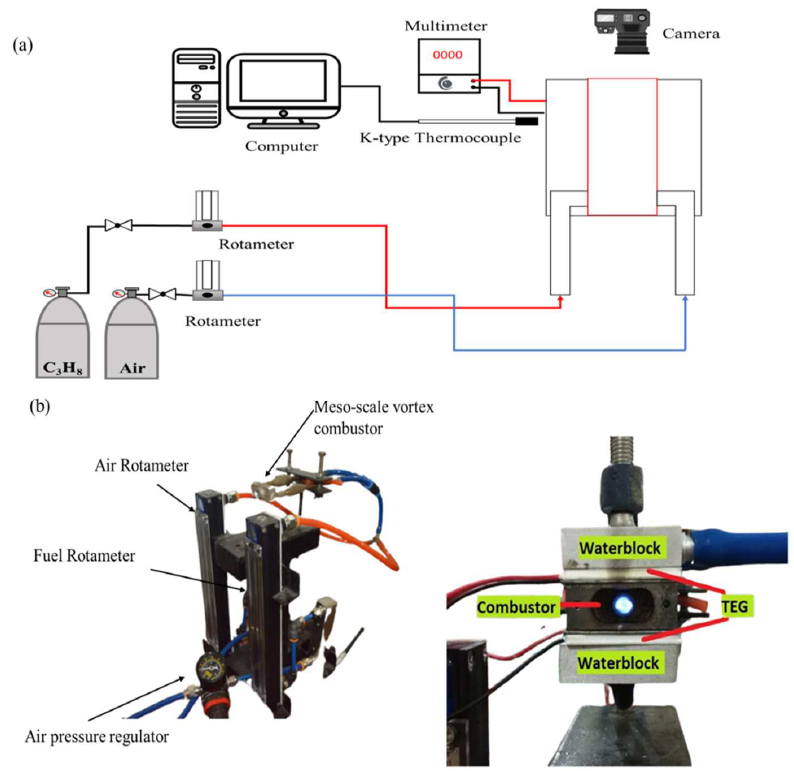
Figure 1. ( a ) Experimental apparatus ( b ) actual photograph of experimental setup and combustor layout.